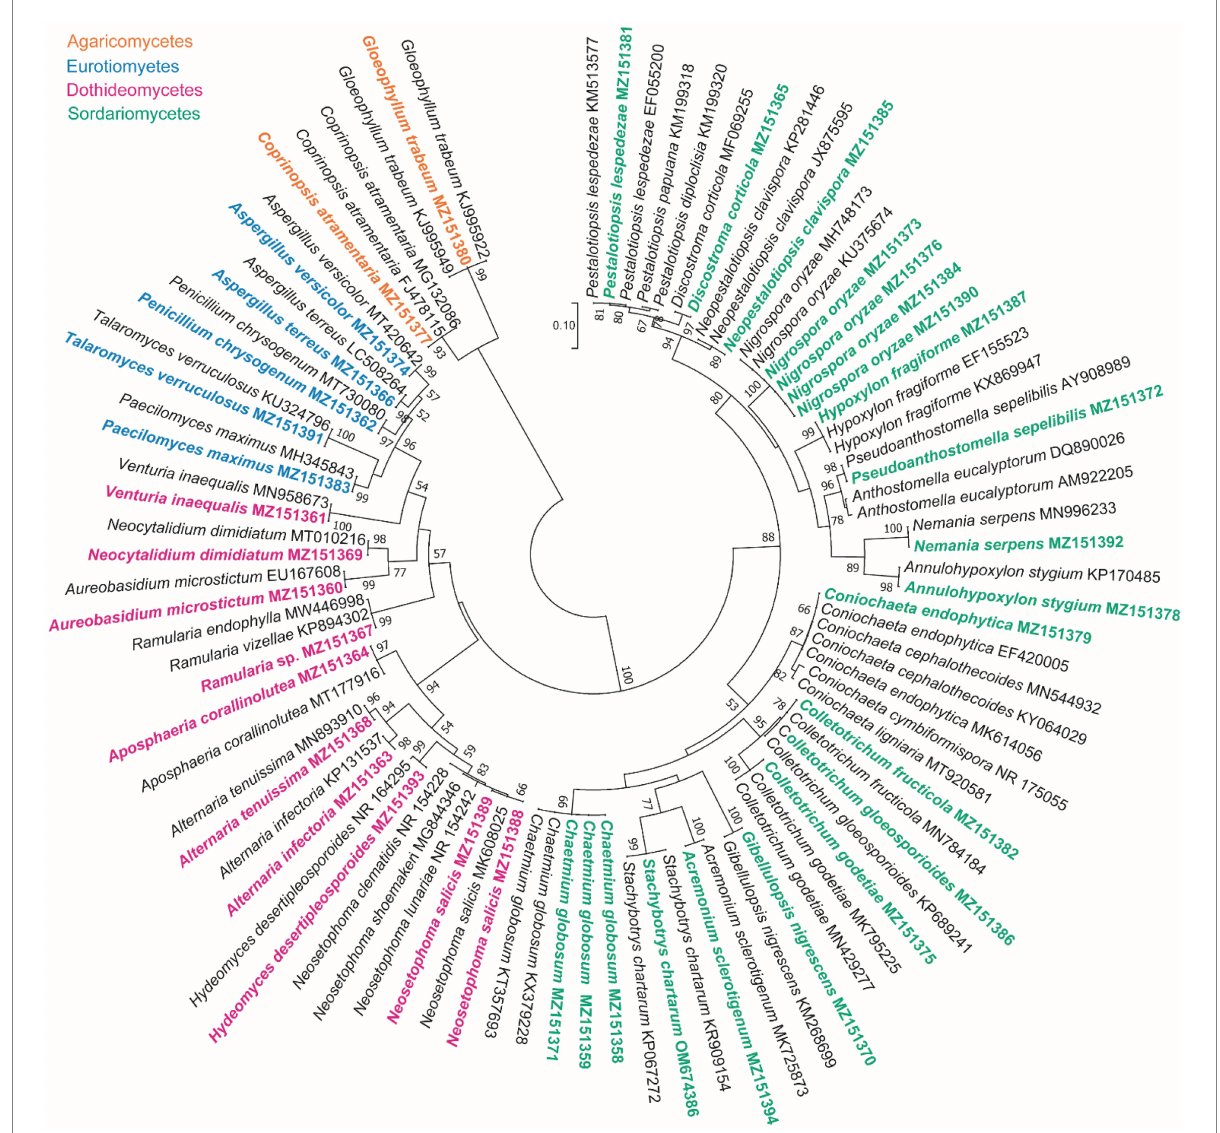
FIGURE 6 Maximum Likelihood (ML) tree based on aligned sequences of ITS region of 92 isolates generated in MEGA 7 under K2 + G model. Bootstrap values (1,000 replicates) indicated at the nodes. The scale bar indicates nucleotide substitution in ML analysis, values ≥ 50% are shown above/below the branches. The surveyed isolates in the current study are highlighted in